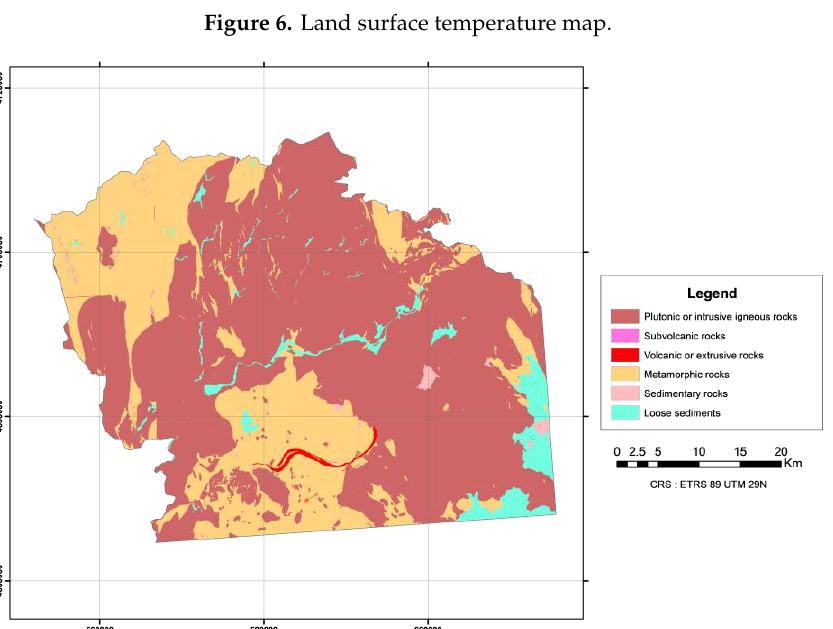
Figure 8. Geological fault and influence zones map. The last layer for the GIS analysis was the gravimetric anomalies map (Bouguer anomalies) as stated in Section 2.1.5. The resampled raster map, cropped for the study area extension, is shown in Figure 9. The low spatial resolution of the data source (grid of 2’ × 2’) is a significant constraint of the present layer.